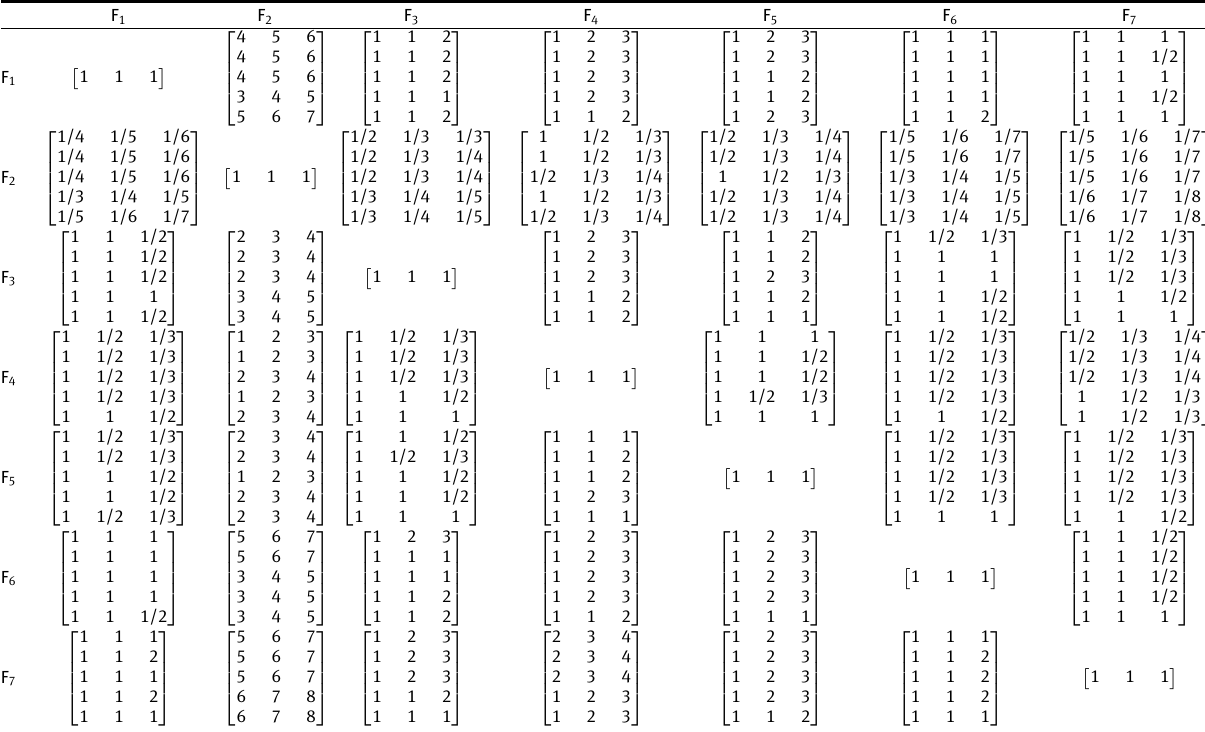
Table 5: Pair wise comparison matrix